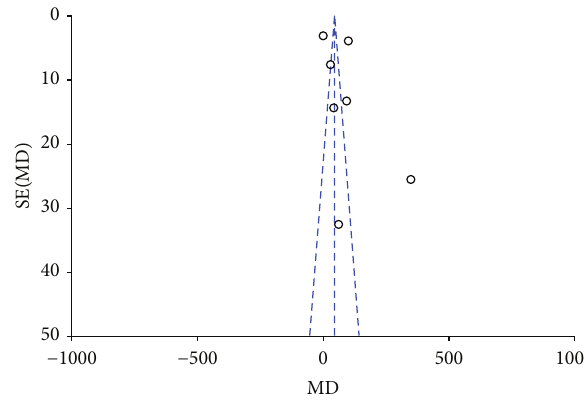
Figure 10: Funnel plot for meta-analysis of the duration of motor